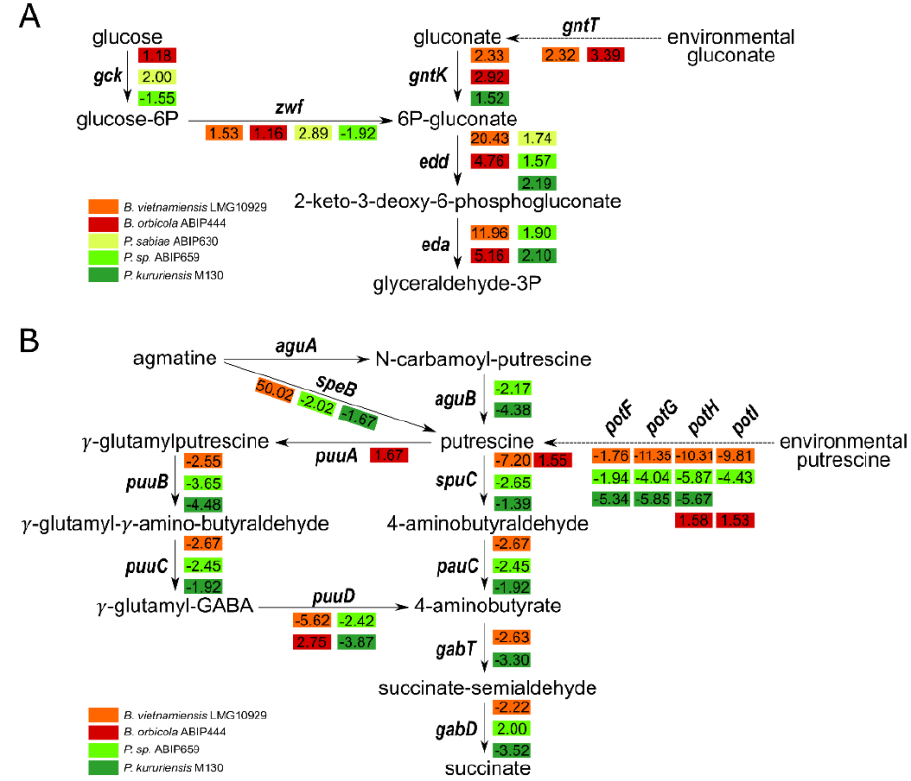
Figure 7 - Regulation of Entner-Doudoroff and putrescine pathways upon root exudates stimulation. For each strain and pathway, the fold-change value is depicted next to the corresponding gene. (A) The Entner-Doudoroff pathway uses glucose as starting product and branches into the glycolysis pathway with glyceraldehyde-3P which is ultimately converted to pyruvate. No significant regulation was found in B. reimsis ABIP441. (B ) Putrescine synthesis, catabolism and uptake pathways in Burkholderia s.l. strains. No significant regulation was found in B. reimsis ABIP441 and P. sabiae